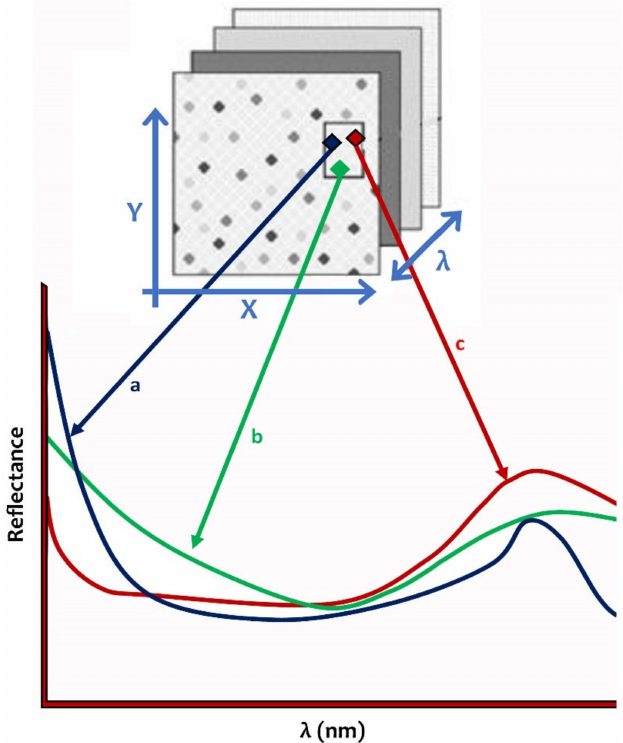
Figure 5. Hypercube representative pixel in a hyperspectrum (modified from